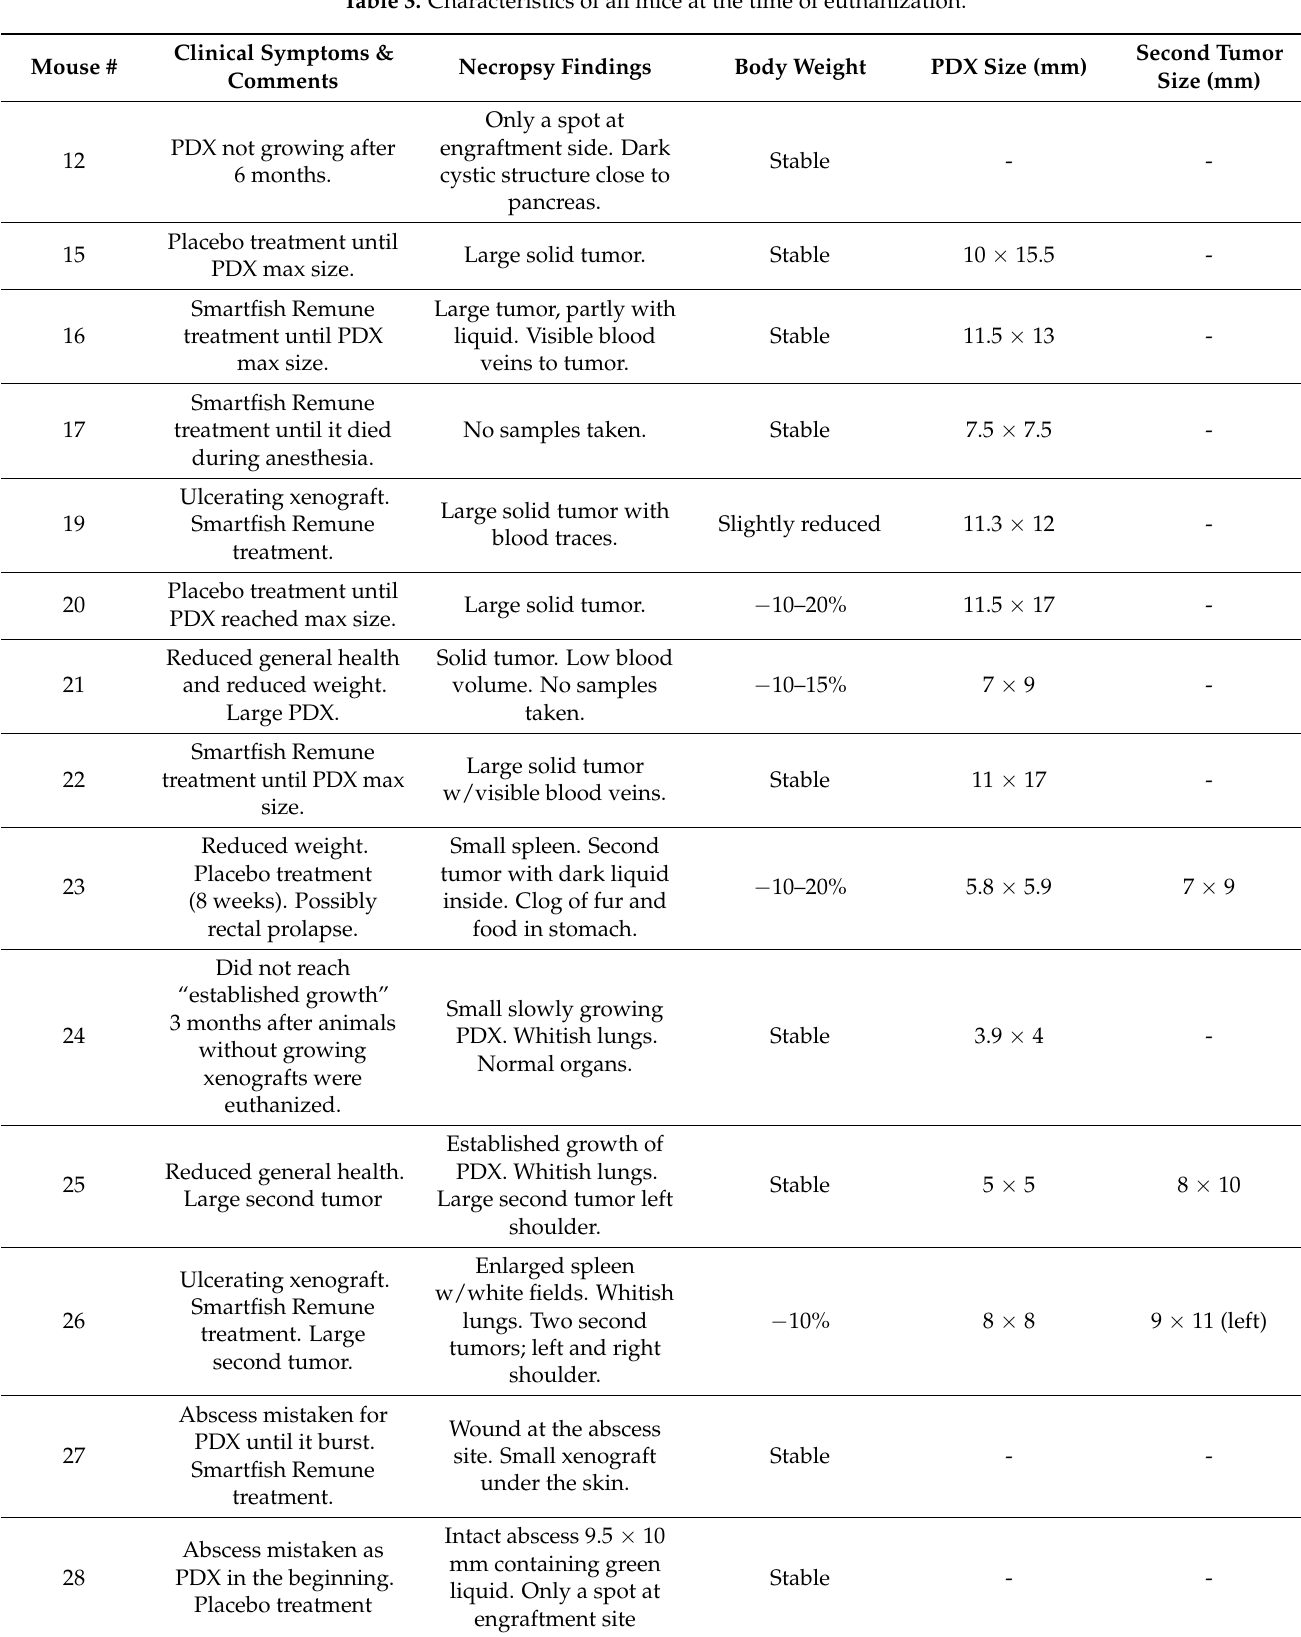
Table 3. Characteristics of all mice at the time of